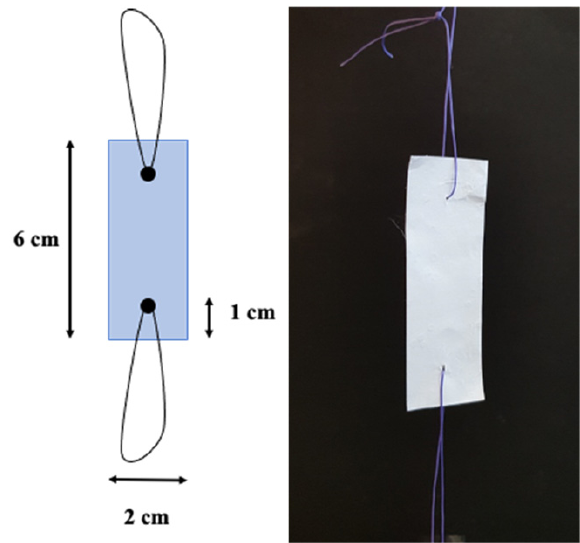
Figure 4. Sutured model for mechanical assessment.